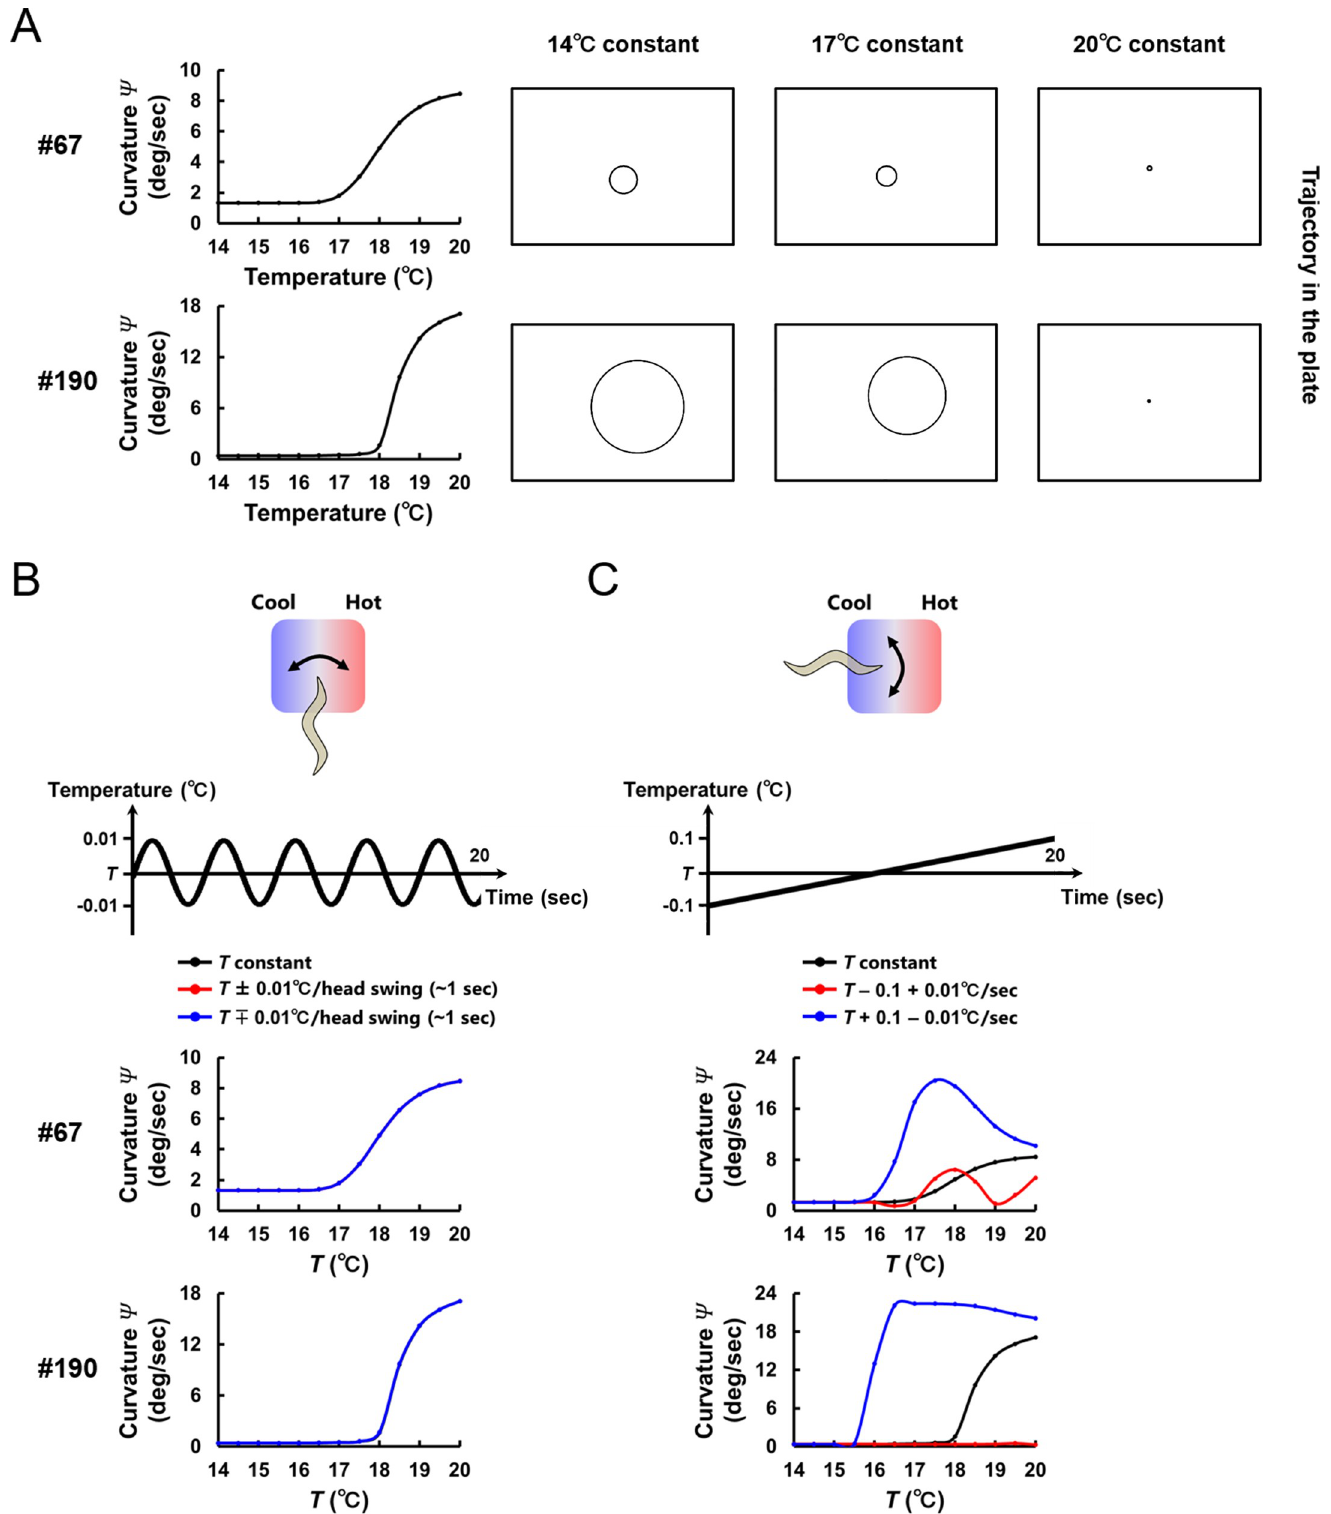
Fig 4. Temperature change on the temporal scale of forward movement modulates curvature in locomotion. (A) Trajectory of the model worms that were set not to perform turning on the constant temperatures ranging from 14 to 20˚C (right panels). The steering curvature C of trajectories is calculated and plotted against